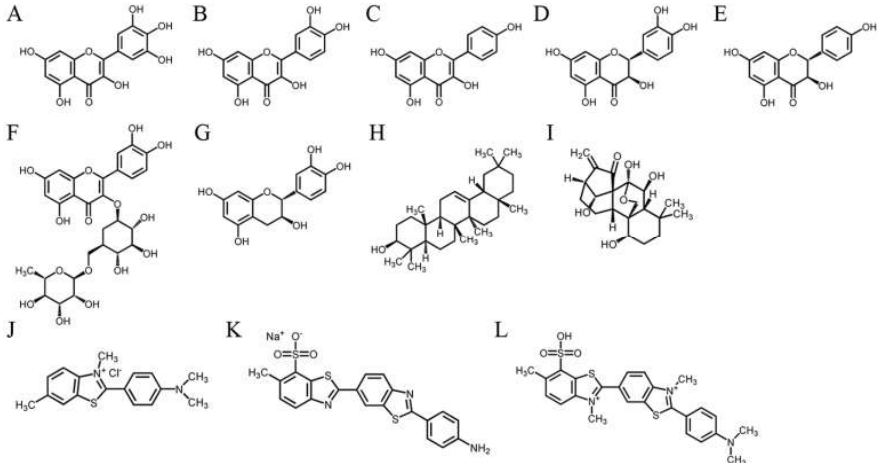
Figure 4. Molecular structure of ( A ) myricetin, ( B ) quercetin, ( C ) kaempferol, ( D ) dihydroquercetin, ( E ) dihydrokaempferol, ( F ) rutin, ( G ) catechin, ( H ) β-amyrin, ( I ) oridonin, ( J ) thioflavin T, ( K ) prim- uline, and ( L ) thioflavin S. Thioflavin S is a mixture of compounds used as a fluorescent dye to stain Alzheimer’s plaques. The structure of the major component of thioflavin S is shown according to Wu et al.